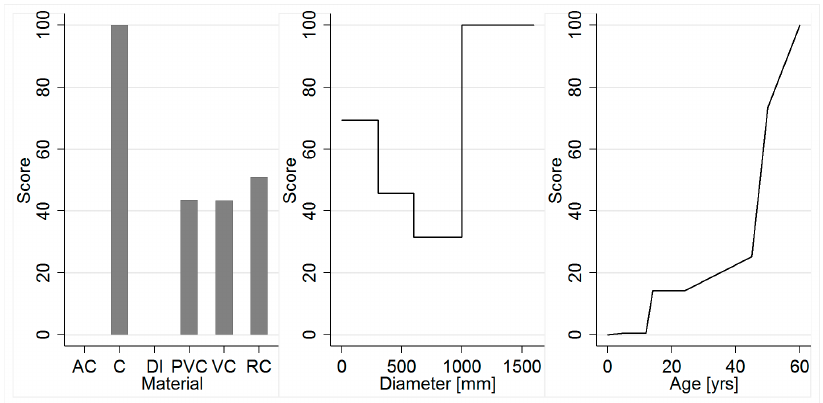
Figure 2. Scores of the condition driven criteria for the sewer network.